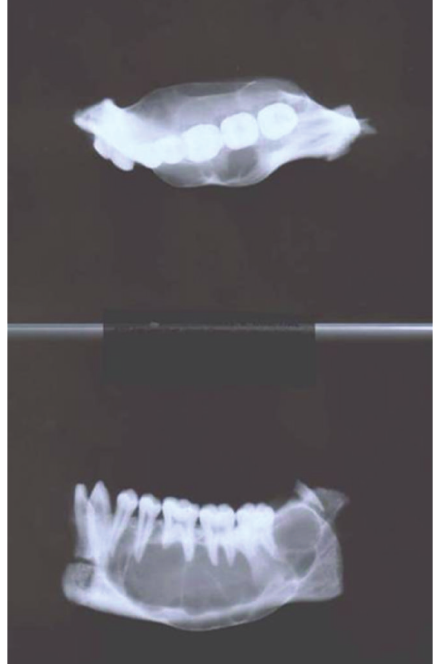
Figure 6: Radiograph of resected segment of right-side mandible.